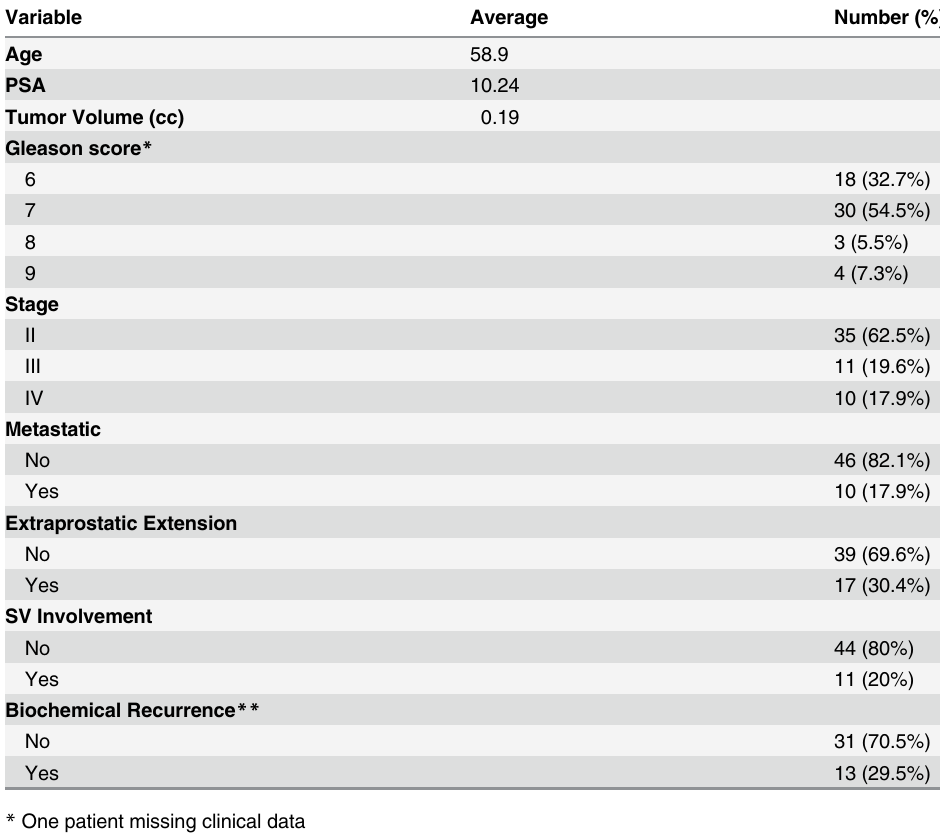
Table 1. Clinicopathologic Characteristics of Validation